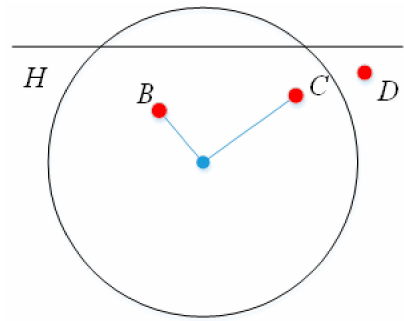
Figure 3. The membership function design based on the position of samples and the